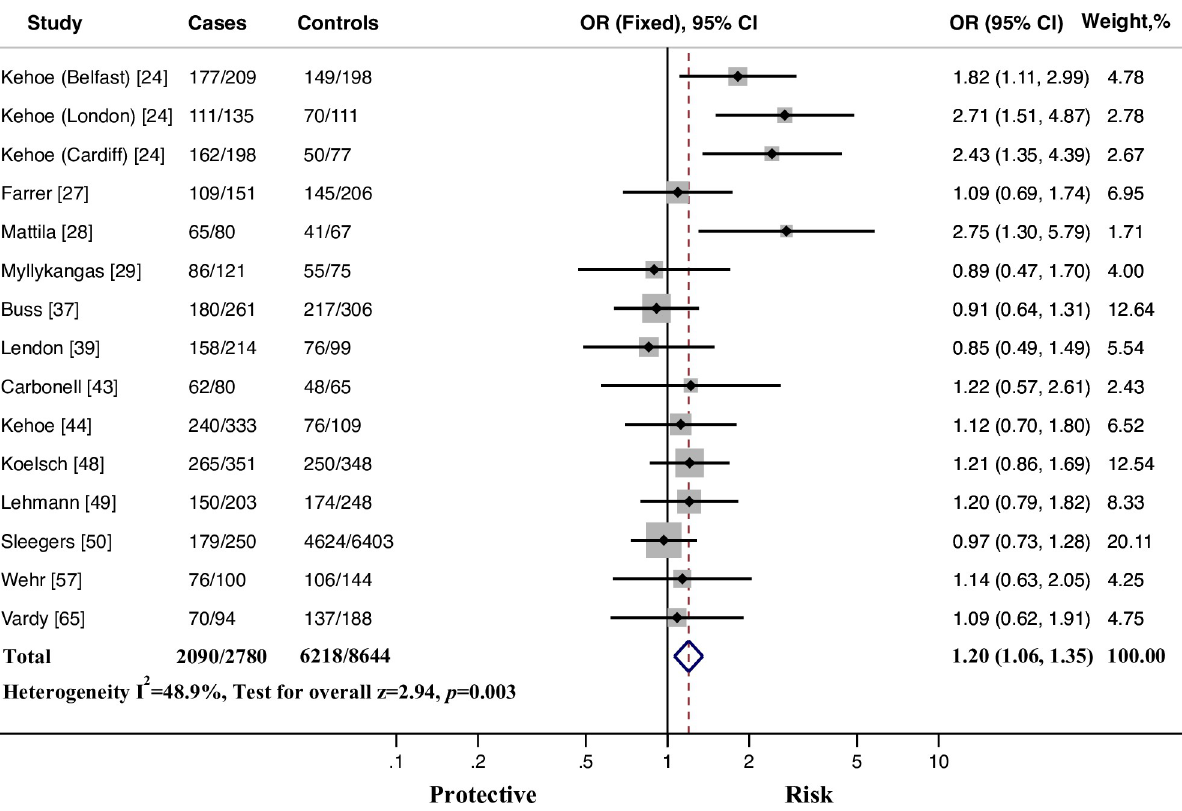
Fig 4. Fixed-effects odds ratio (OR) for the association of ACE rs1799752 I / D polymorphism AD susceptibility in North Europeans in accordance with HWE ( II + ID vs DD ). I represents the insertion allele, and D represents the deletion allele. The size of the gray box is proportional to the weight of the corresponding study. The pooled estimate is displayed as a diamond. Bars, 95% confidence interval (CI).